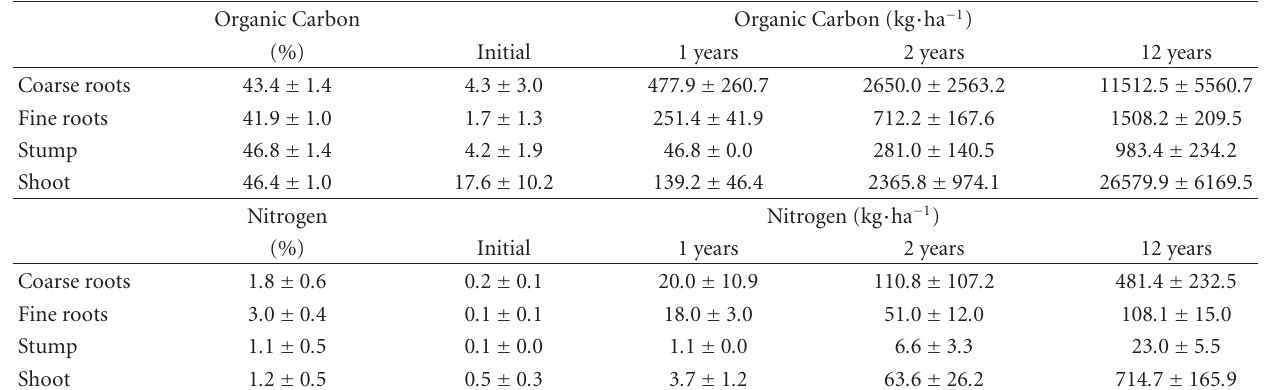
Table 3: Average contents (all samples combined) and stocks of carbon and nitrogen in the woody biomass compartments (coarse roots, fine roots, stump and shoot) of seedlings (“Initial”) and three di ff erently aged stands of Robinia pseudoacacia (standard deviation is given as